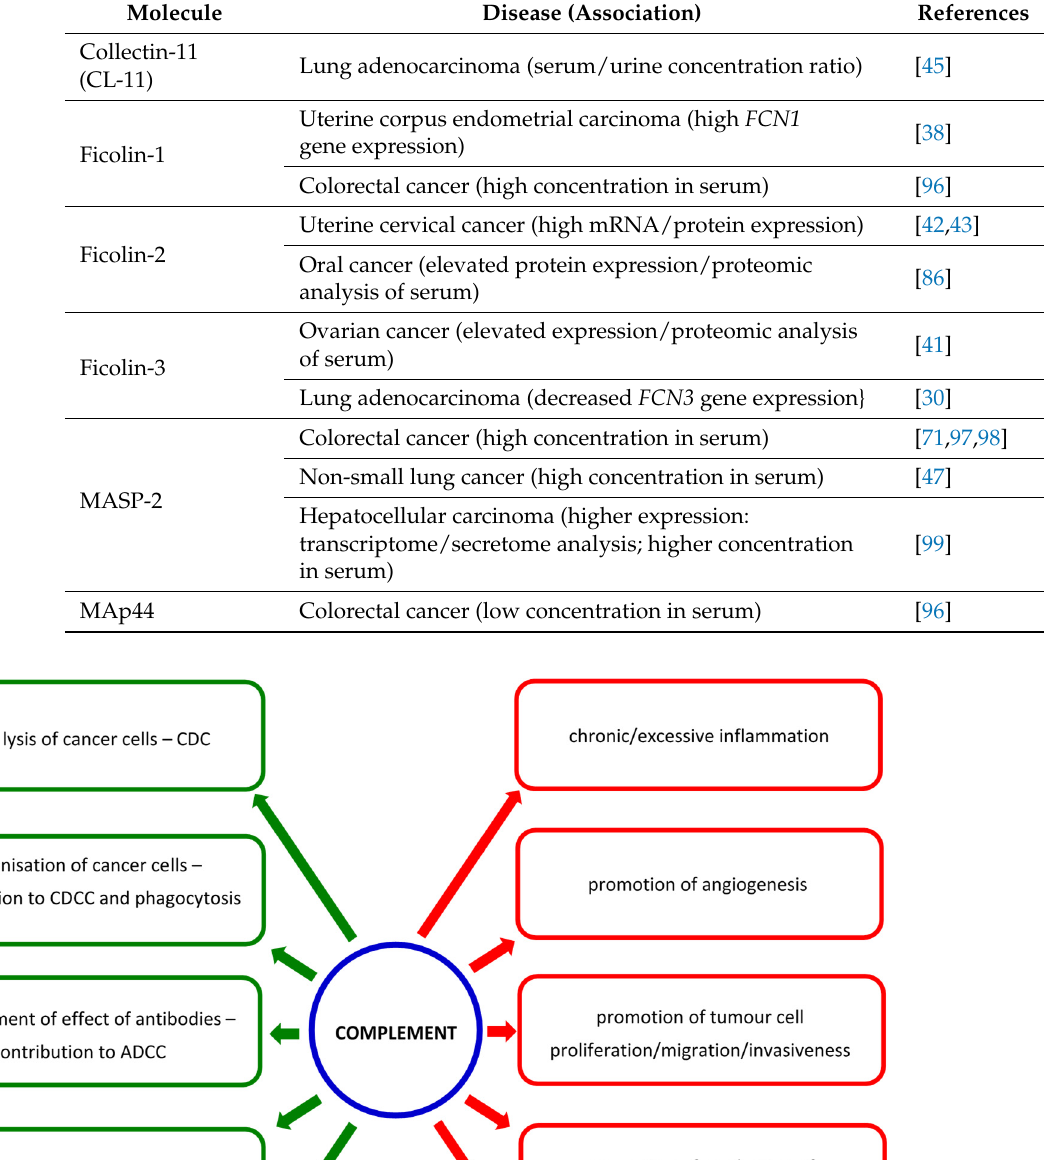
Table 1. Components of the lectin pathway of complement as candidate biomarkers of solid tumour cancers.